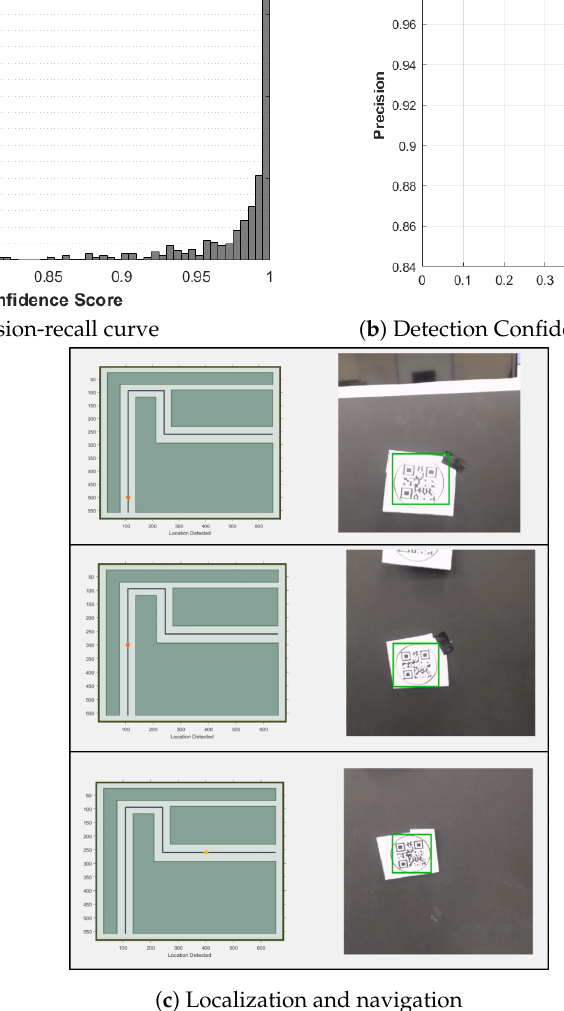
Figure 17. Detection performance for the Quick Response (QR) robot localization and